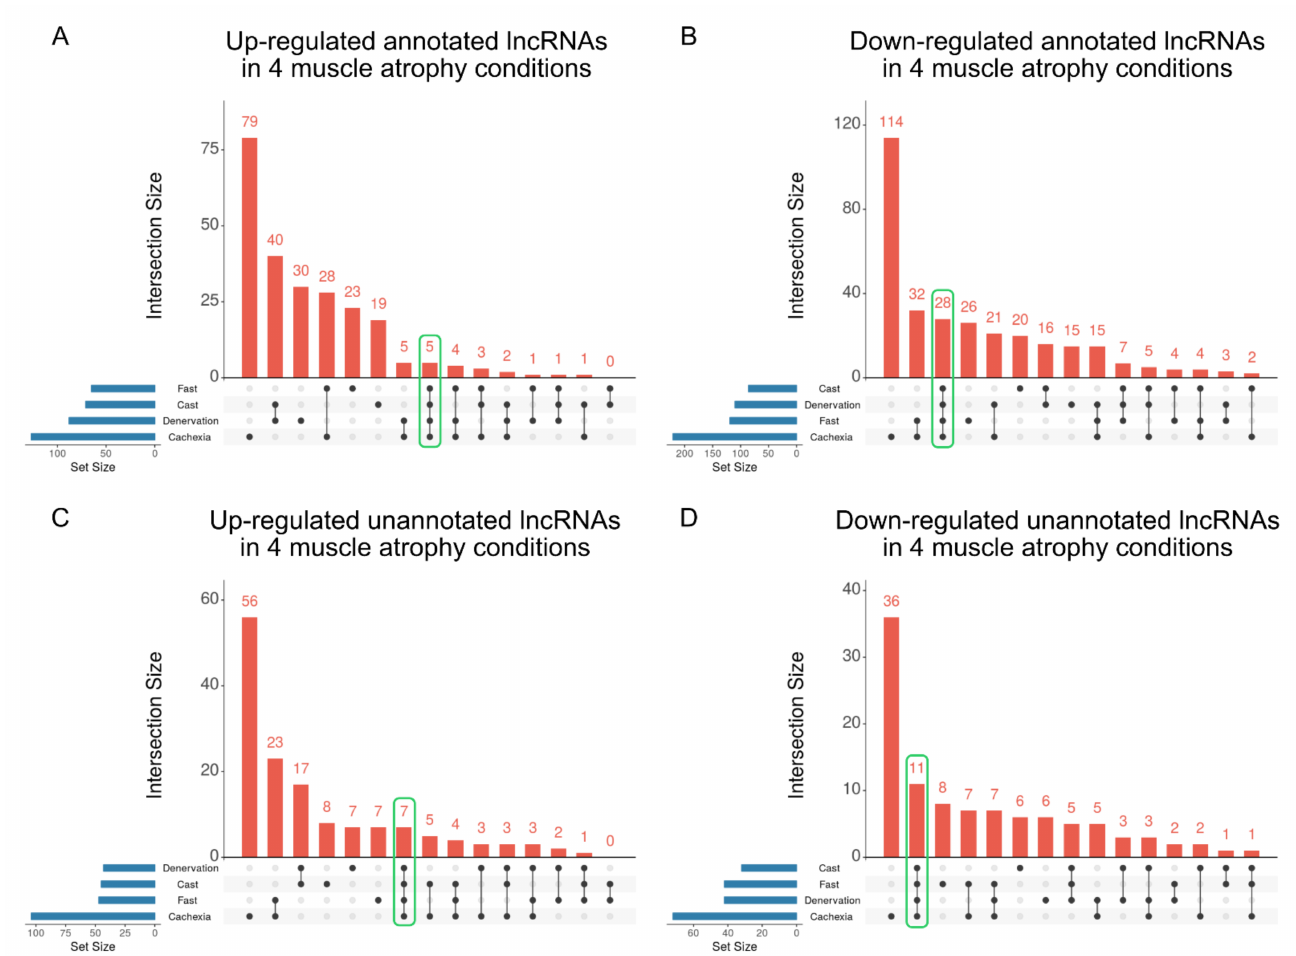
Figure 5. Identification of lncRNAs that are commonly altered in four muscle atrophy conditions. The UpSet plot represents the number of up- ( A ) or down-regulated ( B ) annotated lncRNAs by conditions identified by linked dots below the x -axis. Set sizes related to blue horizontal bars represent the total number of differentially expressed lncRNAs for each condition. The intersections represent the up- ( C ) or down-regulated ( D ) unannotated lncRNAs among muscle atrophy conditions. The number of lncRNAs that were commonly altered in all four muscle atrophy conditions is encircled by the green